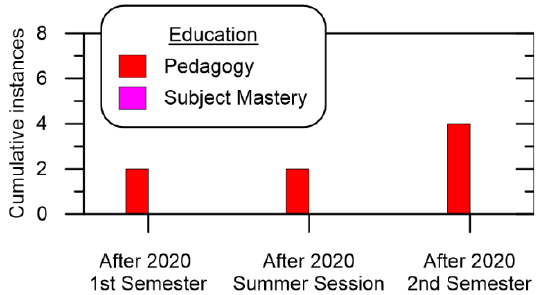
Figure 4. Cumulative Educational impact over time.